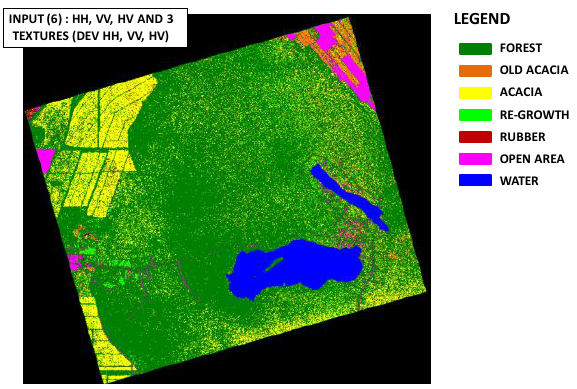
Figure 5. Land cover classification using 10 spatial resolution with 3 polarization images and 3 texture